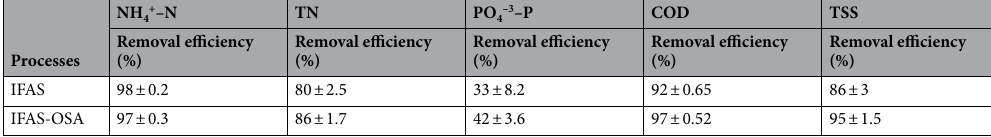
Table 3. Nitrogen, phosphorus, TSS, and COD removal percentages in the effluents of the IFAS and IFAS- OSA system.